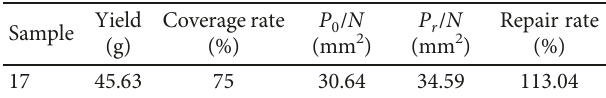
Figure 6: Particle size distribution of the best microcapsule. Table 12: Comprehensive properties of microcapsules prepared by optimization.